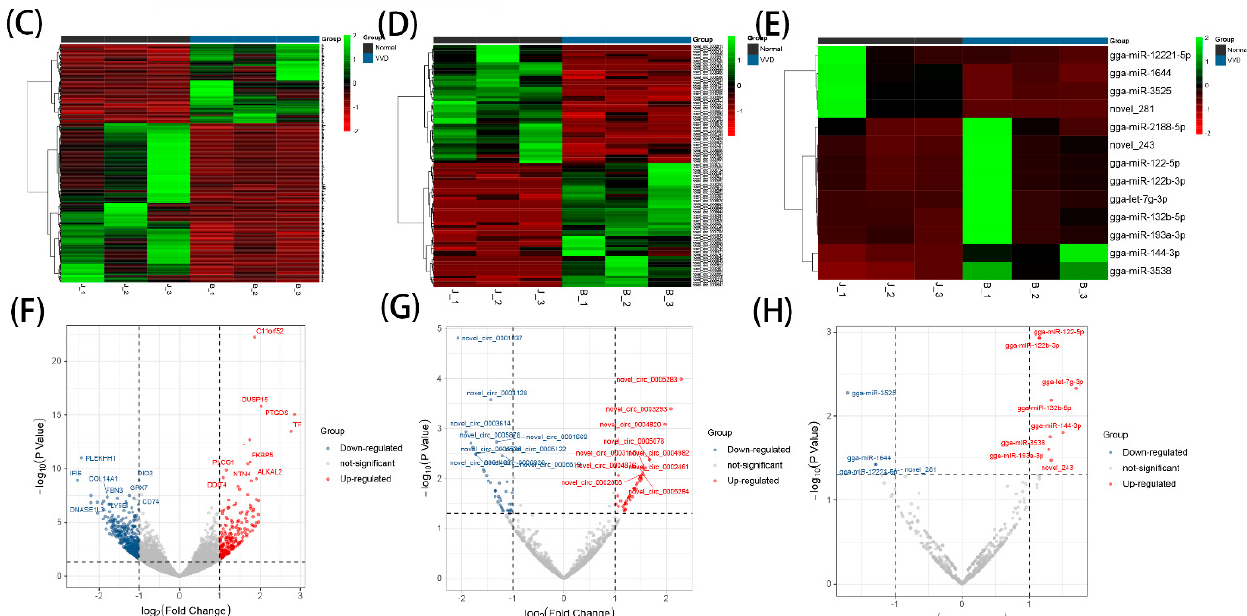
Figure 1. Flowchart of the research design and identification of differentially expressed circRNAs, miRNAs and mRNAs: ( A ) flowchart of the research design; ( B ) analysis of the type of DEcircRNAs; ( C ) heatmap of DEmRNAs; ( D ) heatmap of DEcircRNAs; ( E ) heatmap of DEmiRNAs; ( F ) volcano plot of DEmRNAs; ( G ) volcano plot of DEcircRNAs; ( H ) volcano plot of DEmiRNAs.